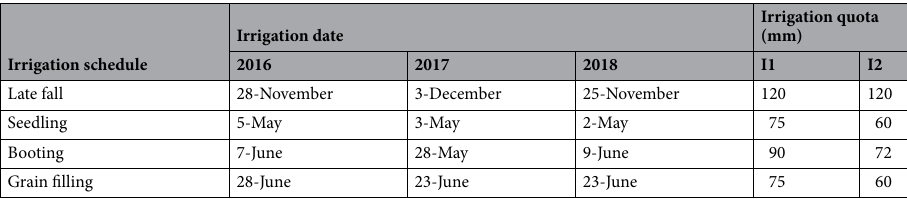
Table 2. Supplemental irrigation dates and quotas at the main growth stages of wheat, at the Oasis Agricultural Experimental Station, with the same schedule and amount being used for each of the experimental